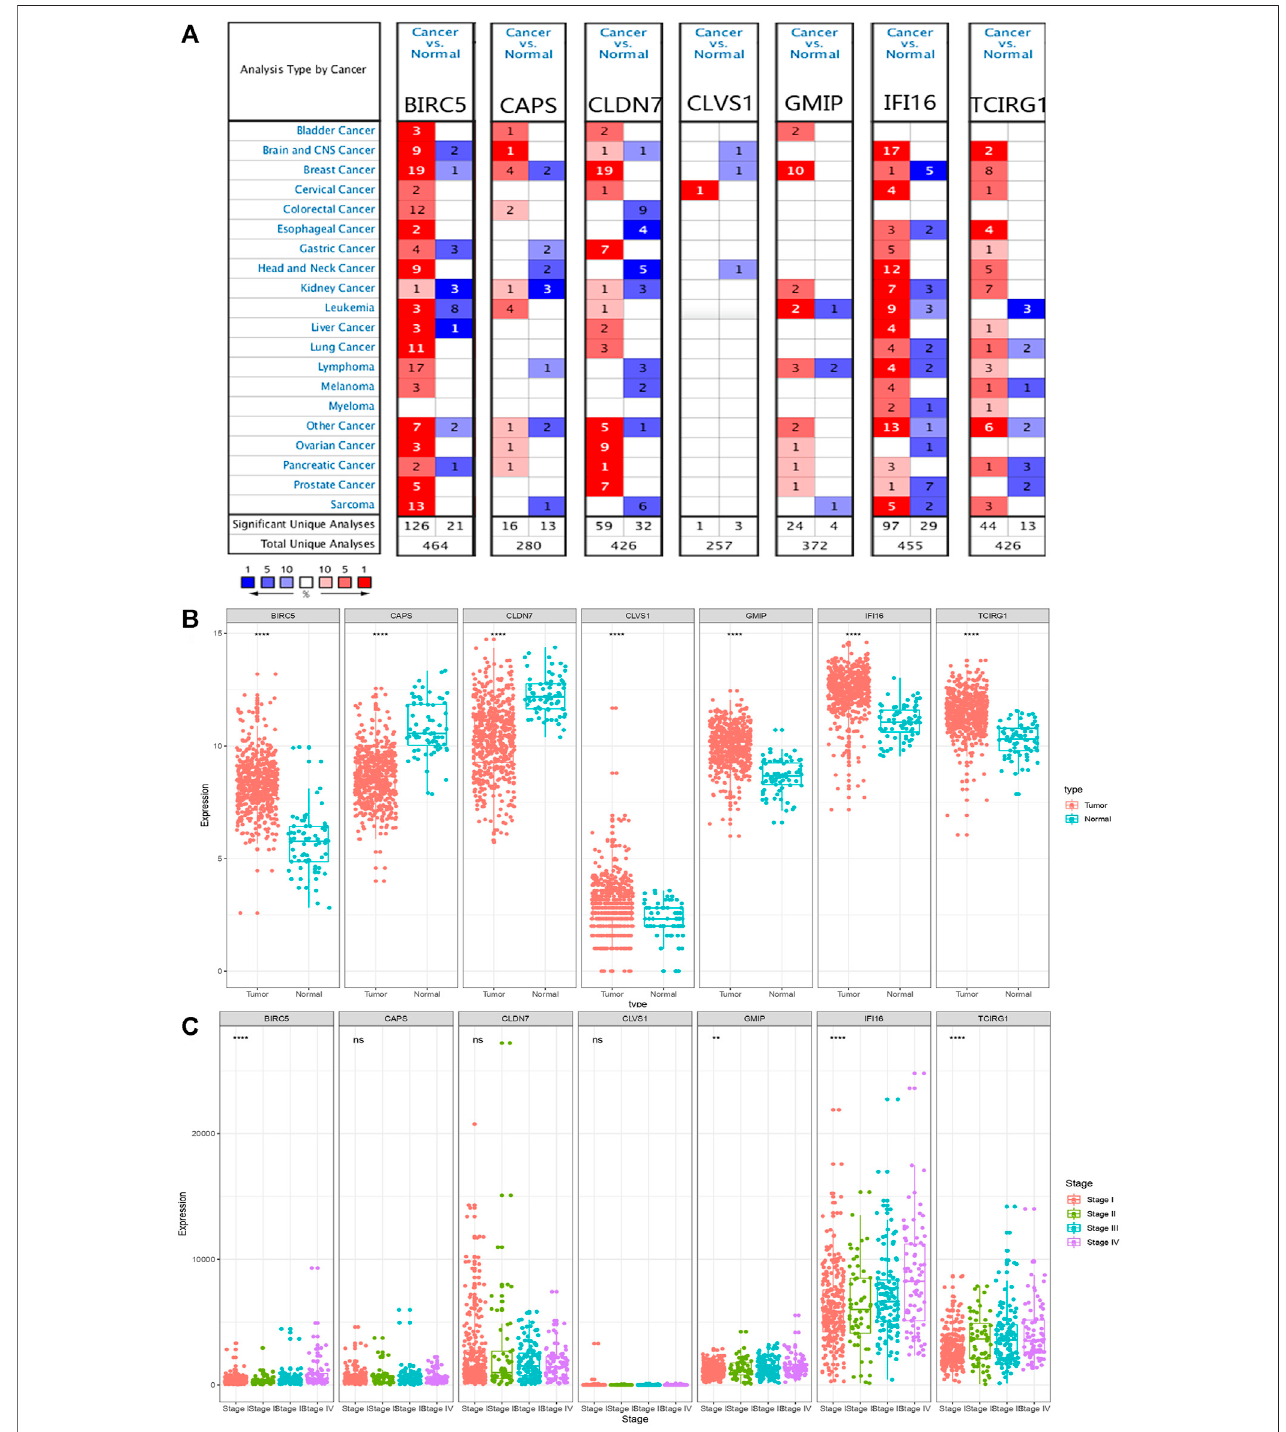
FIGURE2| mRNAexpressionlevelsofDEGs. (A) mRNAexpressionlevelsofDEGsfromONCOMINEdatabase.Thethreshold( p < 0.05,|log 2 FC| ≥ 1.5,generank: Top 10% datatype: mRNA) was indicated in the colored cells. The red cells indicated the target gene was overexpressed in ccRCC while blue cells represented downregulatedinccRCC.Generankwasdepictedinthecolordepthinthecells. (B) mRNAexpressionlevelsofDEGsinccRCCandnormaltissuefromTCGAdatabase. p value was replaced by “ *, ” ns p > 0.05, * p < 0.05, ** p < 0.01, *** p < 0.001 and **** p < 0.0001. (C) Different mRNA expression levels of DEGs in different stages.